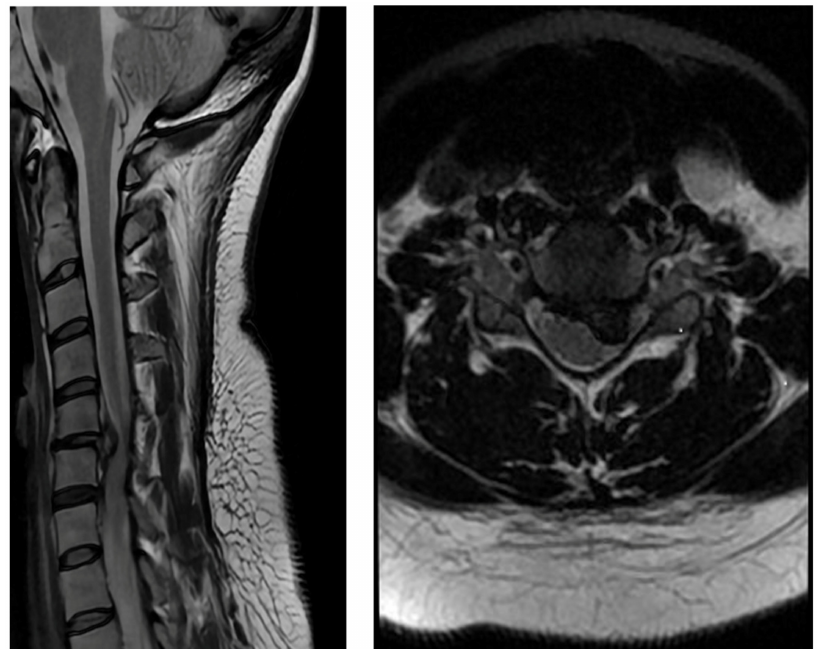
Figure 1. Preoperative MRI scan showing a large, herniated disc with spinal cord compression.